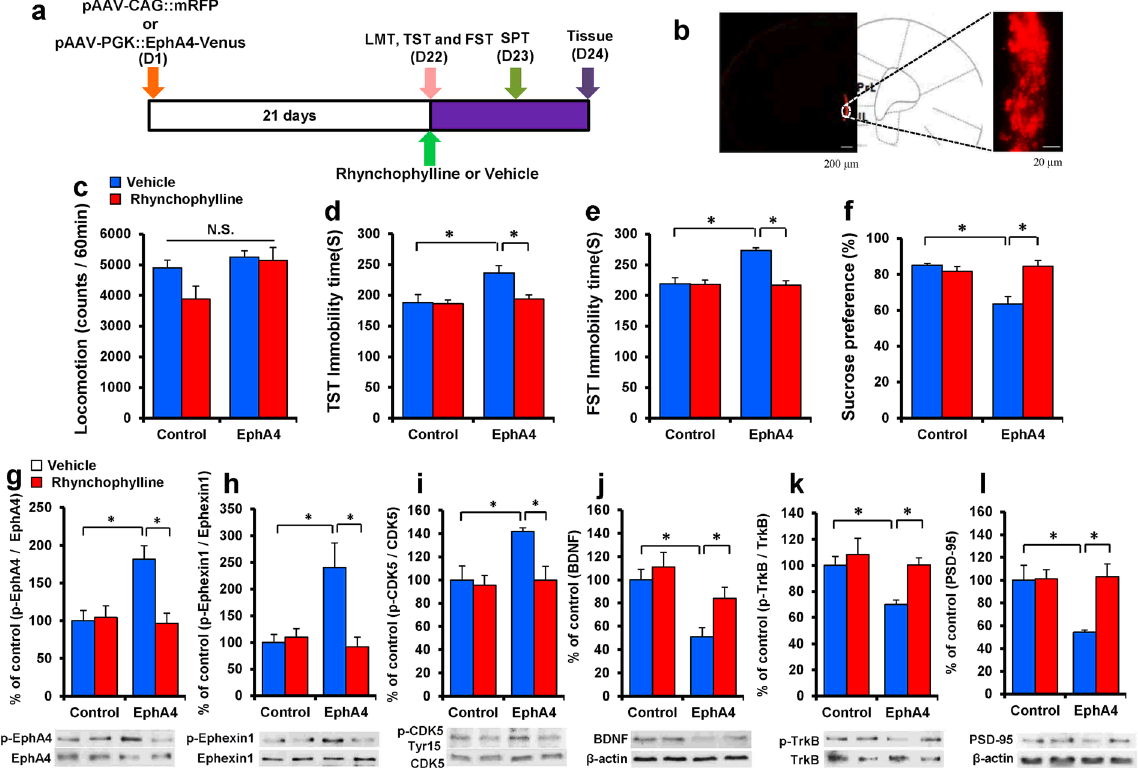
Figure 6. Depression-like phenotype after bilateral injection of pAAV-PGK:: EphA4-Venus into the mPFC. ( a ) Schedule of pAAV vector injection, drug treatment, and behavioral tests. ( b ) Representative photographs of the injection sites and coronal brain sections in the mPFC. The success of AAV vector injection into the mPFC was confirmed by the presence of mRFP fluorescence. Scale bars = 200 μ m (low-power images) and 20 μ m (high-power images). ( c ) LMT. ( d ) TST. ( e ) FST. ( f ) SPT. The values represent the mean ± S.E.M. (n = 7). * P < 0.05 compared with the vehicle + EphA4 group. N.S.: not significant. ( g ) p-EphA4/EphA4 ratio in the PFC. ( h ) p-Ephexin1/Ephexin1 ratio in the PFC. ( i ) p-Cdk5(Tyr15)/Cdk5 ratio in the PFC. ( j ) BDNF in the PFC. ( k ) p-TrkB/TrkB ratio in the PFC. (l) PSD-95 in the PFC. The values represent the mean ± S.E.M. (n = 5 or